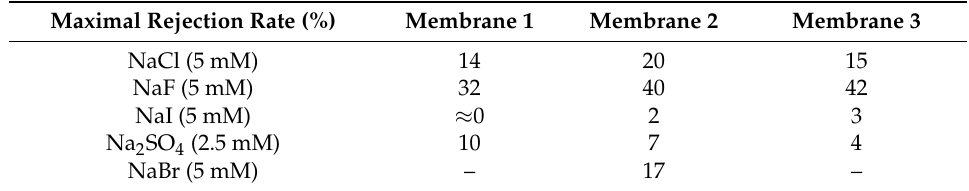
Figure 6. Rejection rate of pure salt-water solutions (NaF, NaCl or NaI—5 × 10 −3 M) vs. permeation flux obtained with membrane 3. Table 2. Maximal rejection rates obtained with membranes 1, 2 and 3 for all the different filtration tests carried out with pure salts ([Na + ] = 5 × 10 −3 M for all the solutions).